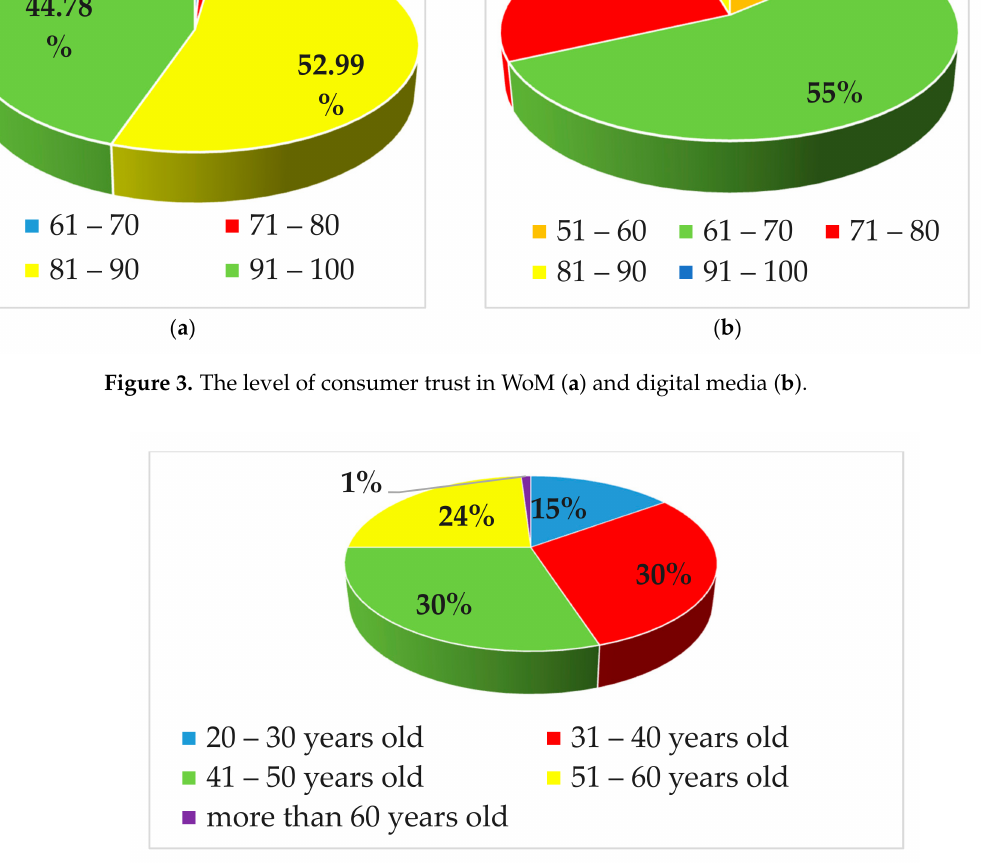
Figure 4. Characteristics of the respondent based on